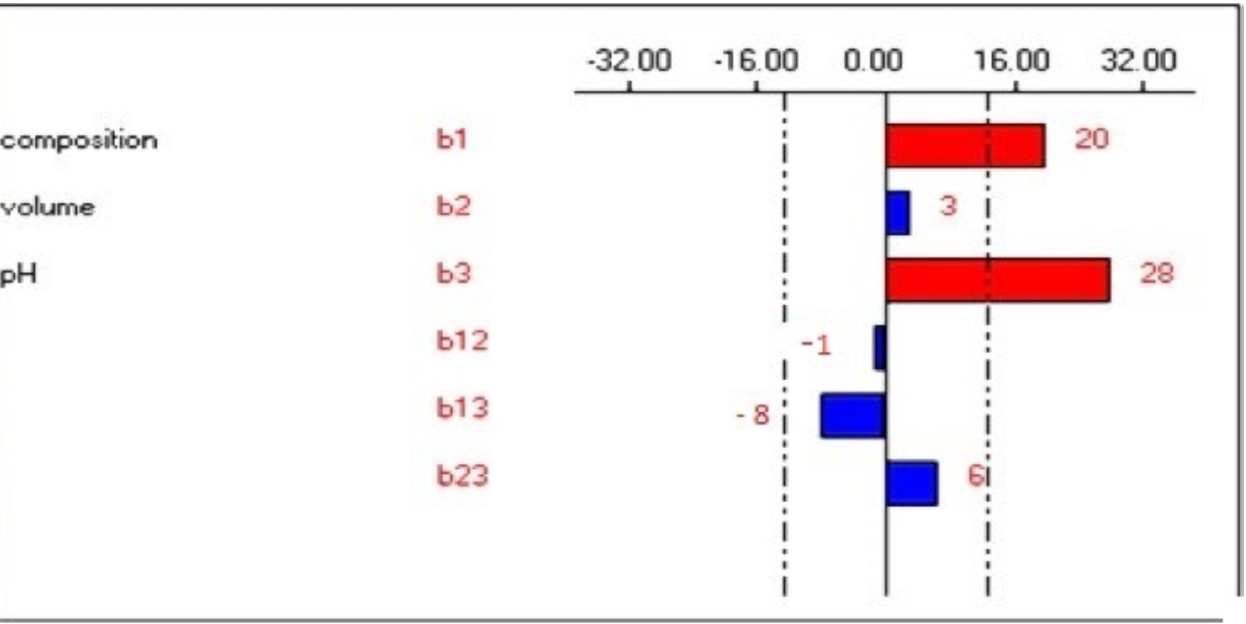
Figure 1. Pareto chart for the elution